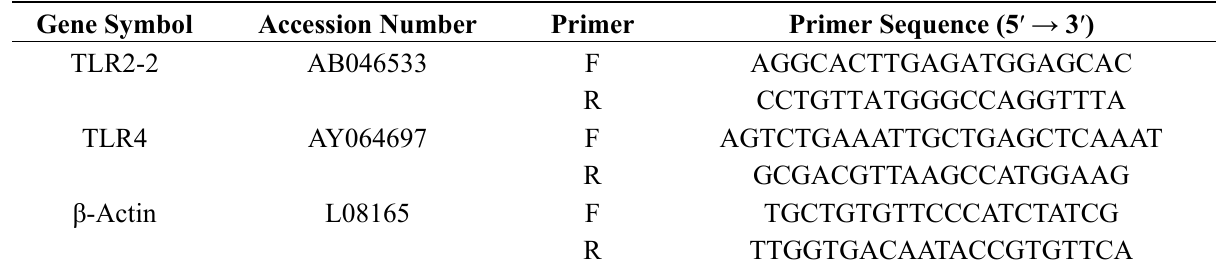
Table 1. A list of oligonucleotides used as primers in qRT-PCR analysis of mRNA expression in the intestinal mucosa and the cecal